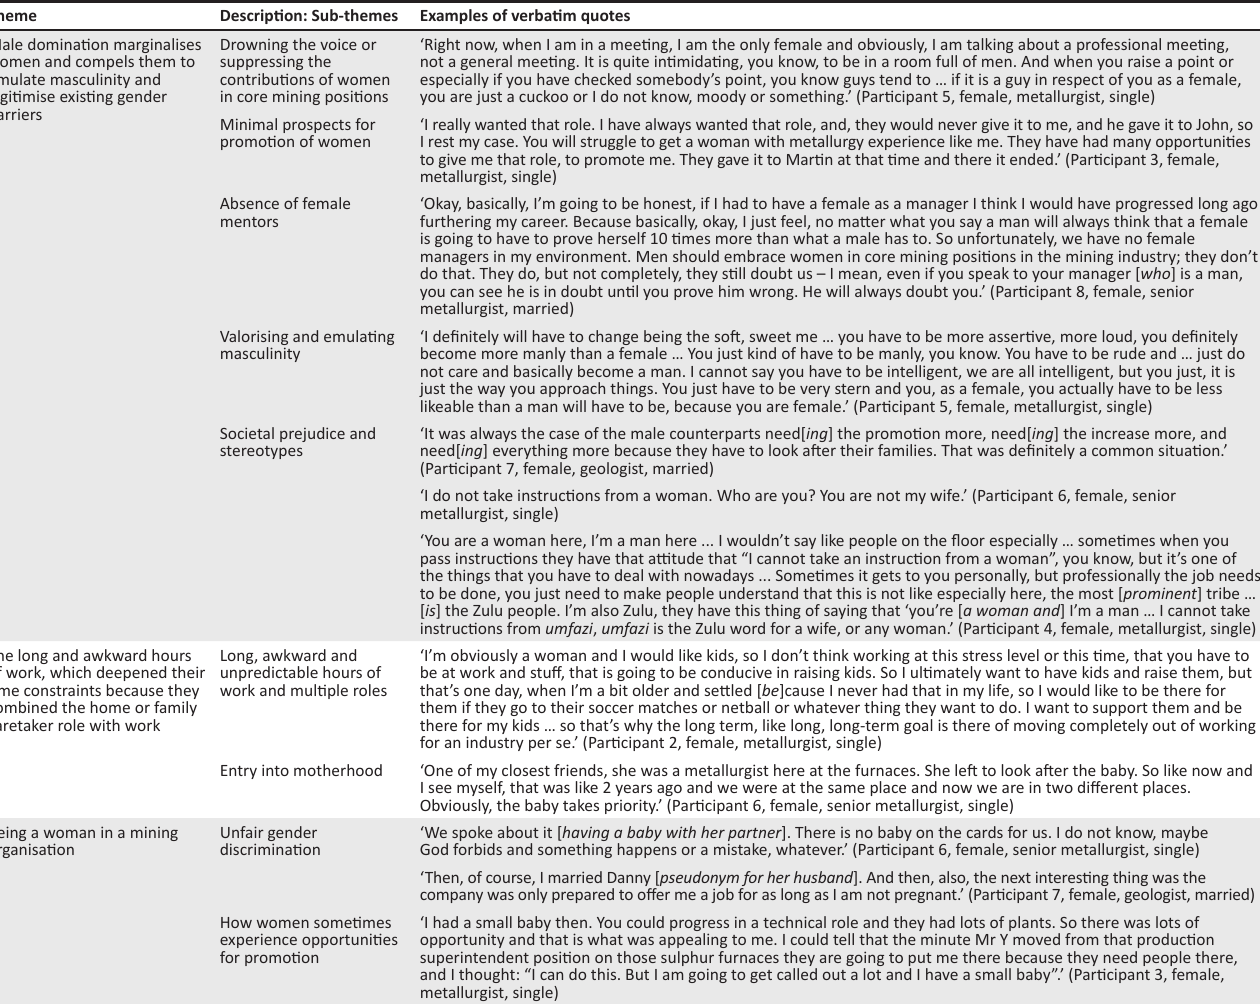
TABLE 2: Themes and verbatim quotes. Theme Description: Sub-themes Examples of verbatim quotes Male domination marginalises women and compels them to emulate masculinity and legitimise existing gender